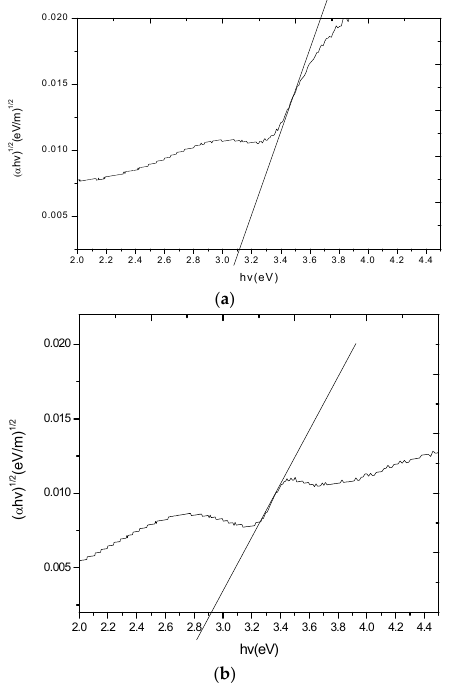
Figure 14. Band gap using Tauc ‐ Plot for sample ( a ) Cu ‐ 00 and ( b ) Cu ‐ 01. Table 4. Kinetic rate for Simazine decomposition catalyzed by ( a ) Cu ‐ 00; ( b ) Cu ‐ 01; ( c ) Cu ‐ 02; ( d ) Cu ‐ 03; and ( e ) Cu ‐ 04 samples under UV irradiation.